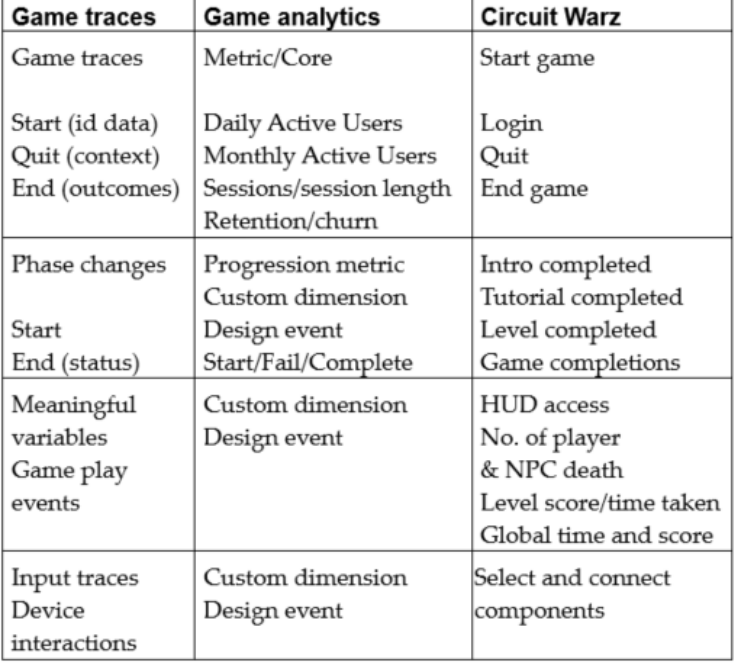
Fig. 12. Mapping for game traces to